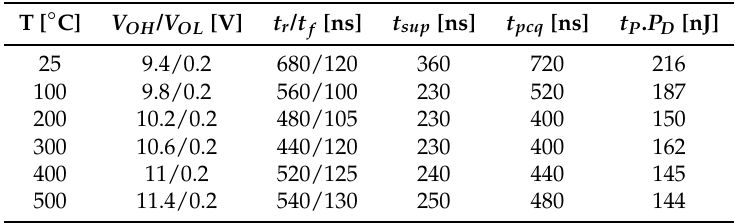
Table 3. DFF performance summary over wide temperature